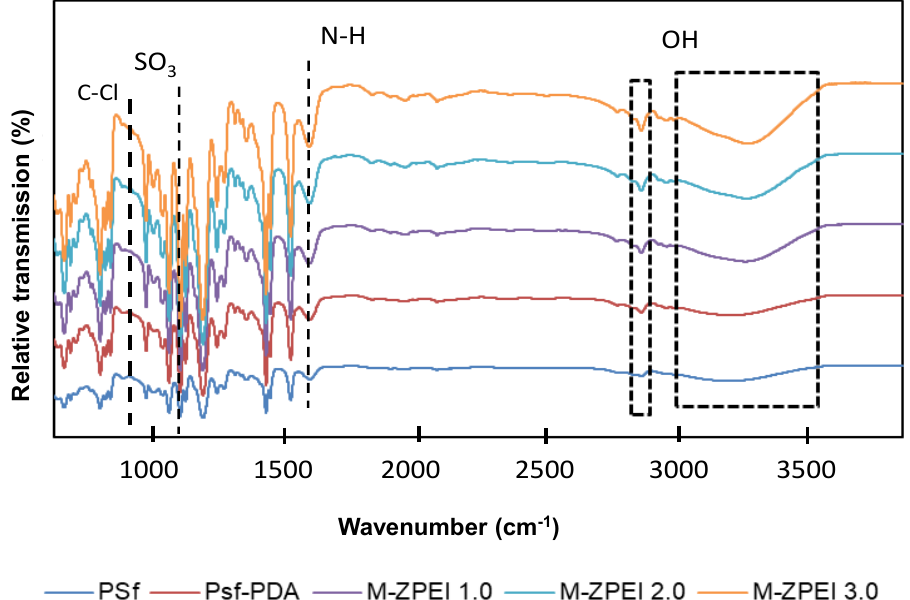
Figure 3. Surface functional group analysis by FTIR of prepared membranes.